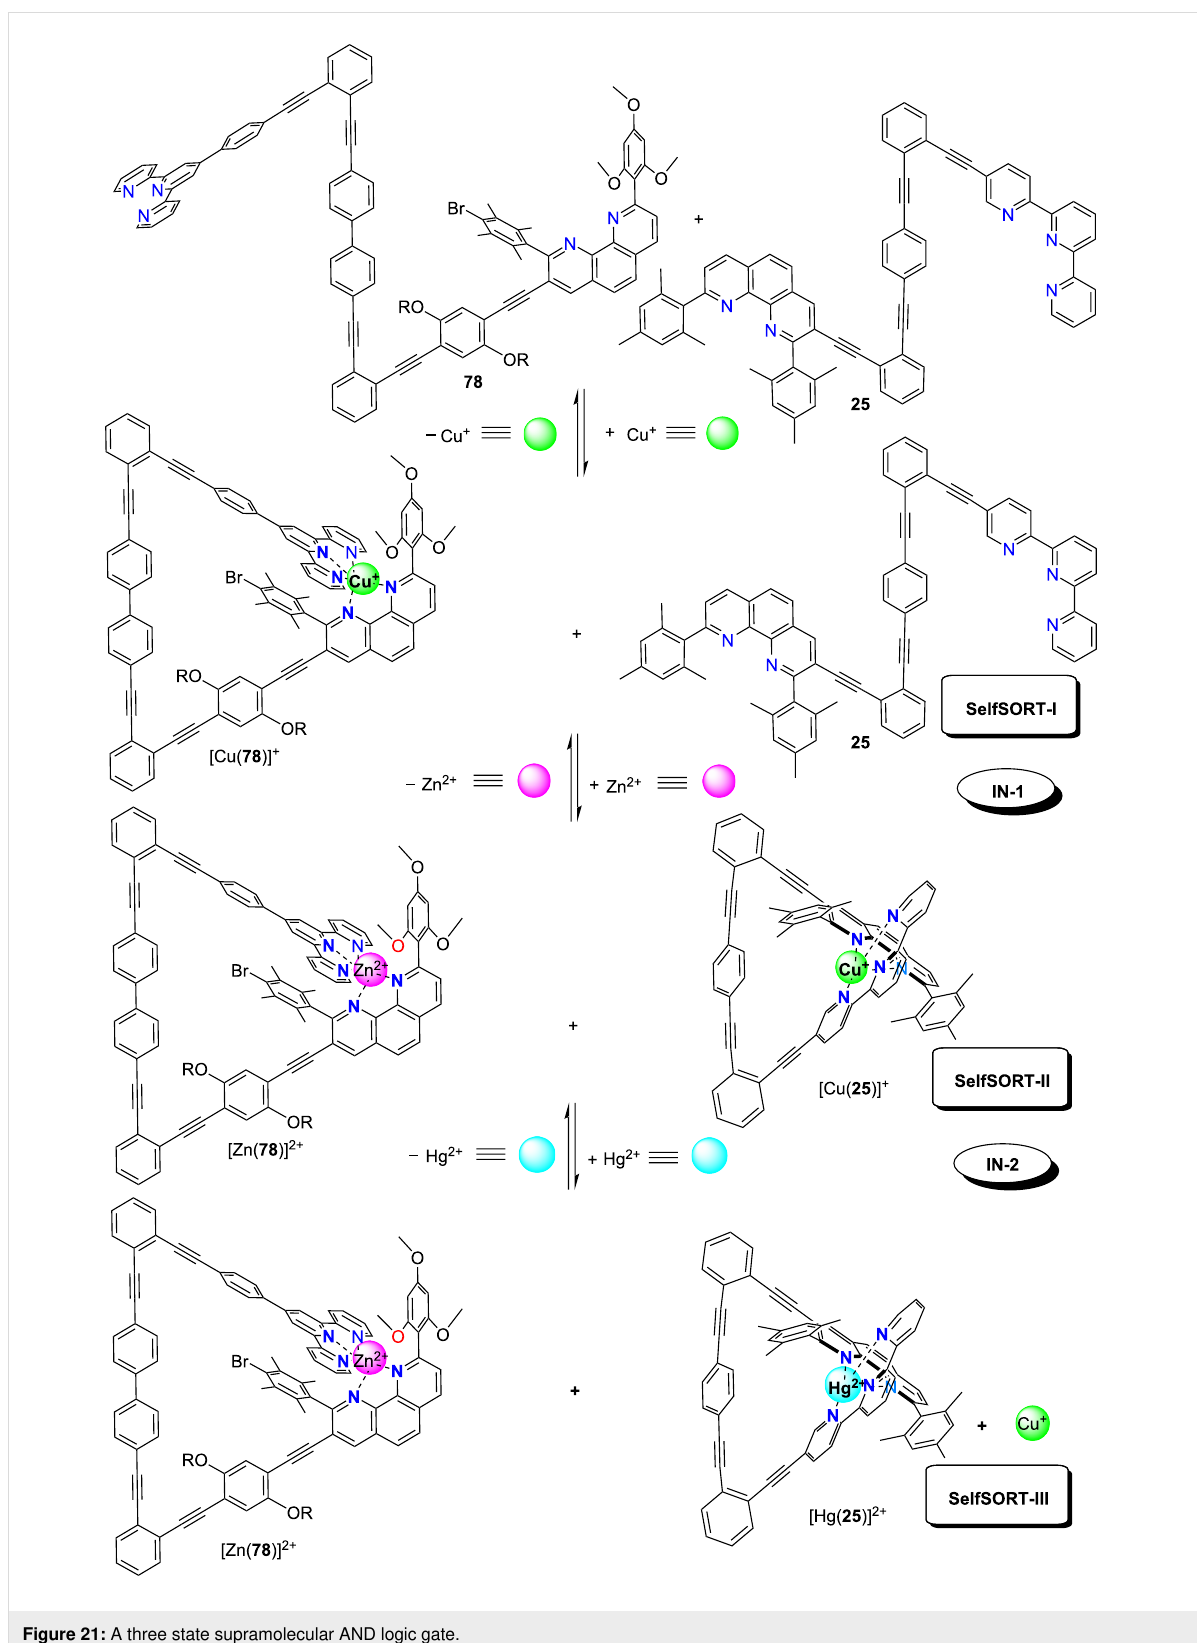
Figure 21: A three state supramolecular AND logic